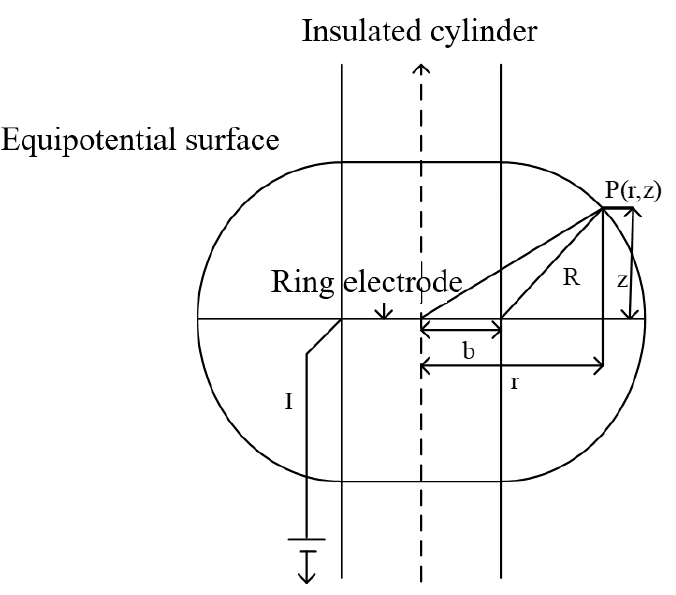
Figure 10. Electric field distribution principle of the ring electrode.